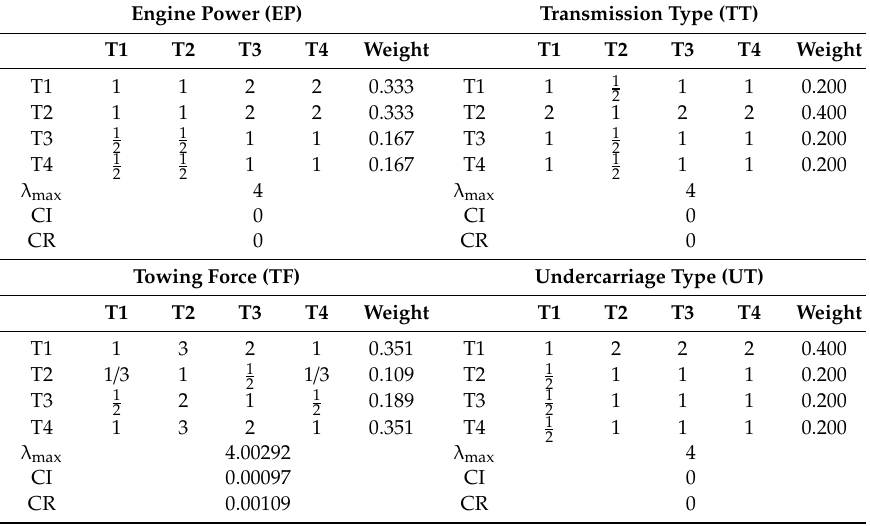
Table 5. Results of the pair-wise comparison of technical sub-criteria EP, TT, TF, UT.